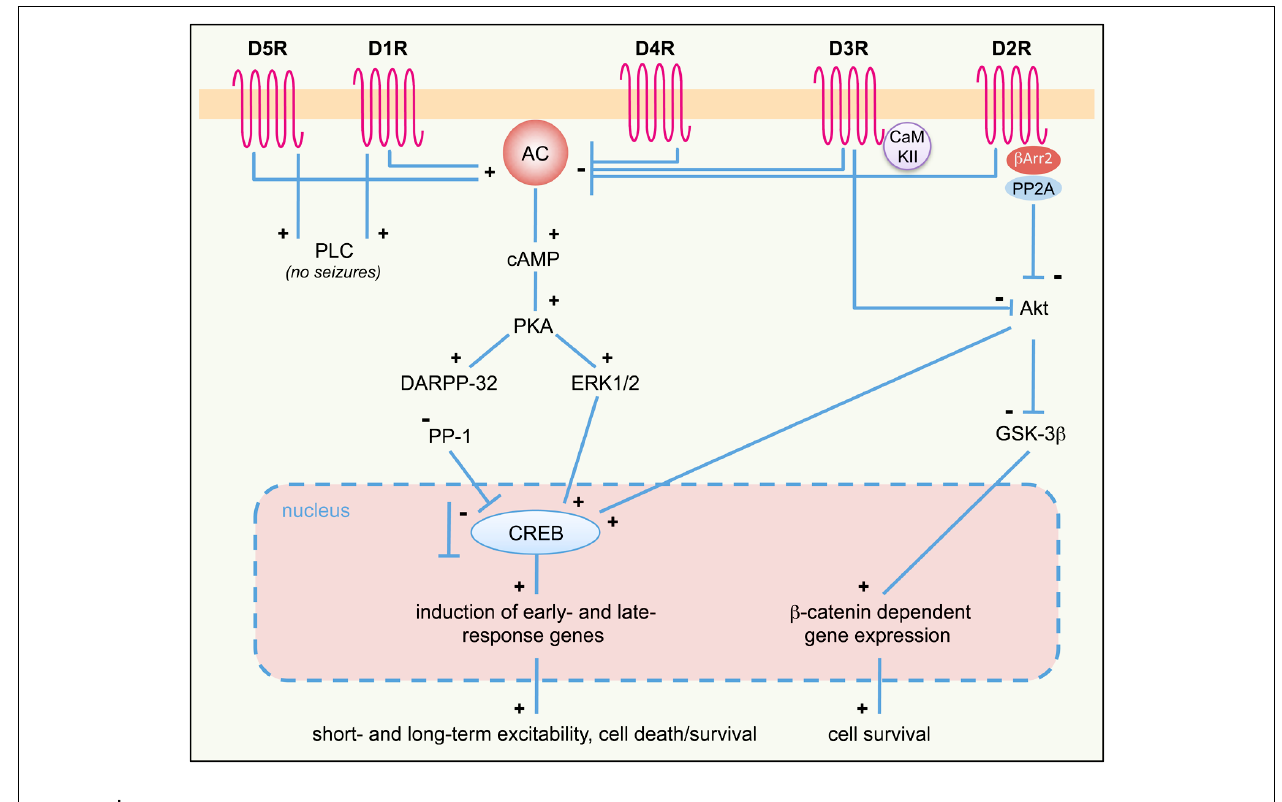
FIGURE 1 | DA receptor signaling pathways activated in response to seizures. D1-like (D1R, D5R) and D2-like (D2R; D3R and D4R) DA receptor differently regulate the AC–PKA–ERK pathway. ERK-regulated gene transcription modulates both short- and long-term responses, including neuronal excitability, survival, and cell death. PLC and Akt pathways are also regulated by D1R/D5R and D2R/D3R, respectively.The proposed scheme is a general (though not complete) summary of the intracellular pathways induced by seizures in the limbic system, where all DA receptor subtypes are expressed. Differences may occur, however, in different limbic